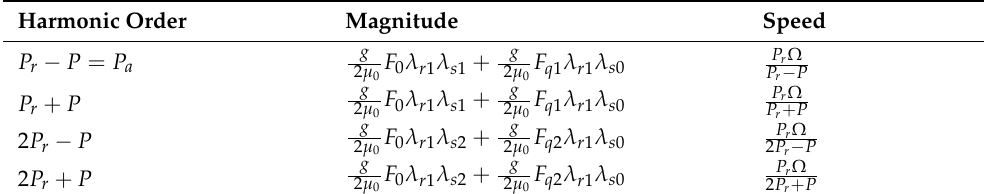
Table 2. Working harmonic magnitude and speed of the consequent pole